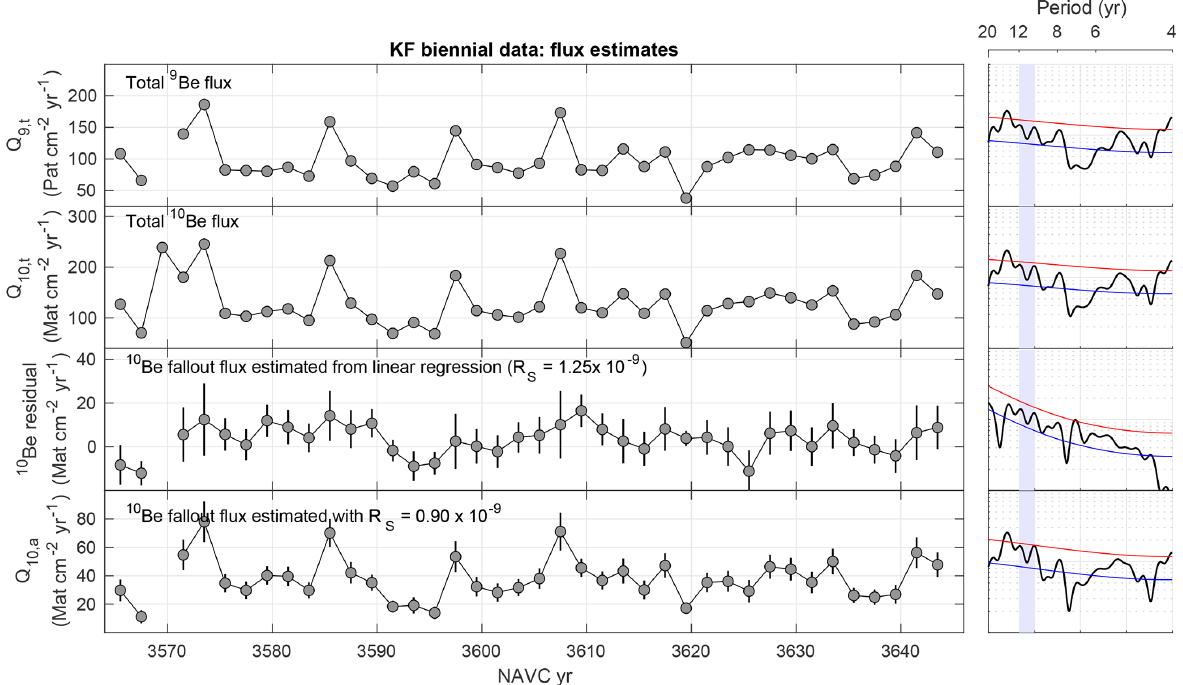
Figure 15. Be flux estimates for the 80-year biennial record at KF. Total fluxes are calculated using the grain size–sediment density relation- ship shown in Fig. 3. Fallout fluxes are estimated from two different assumed values of R S ; see text for details. Error bars reflect propagation of uncertainty on Be isotope concentrations but not on mass accumulation rates. Plot elements for MTM spectra are the same as in Fig. 11.